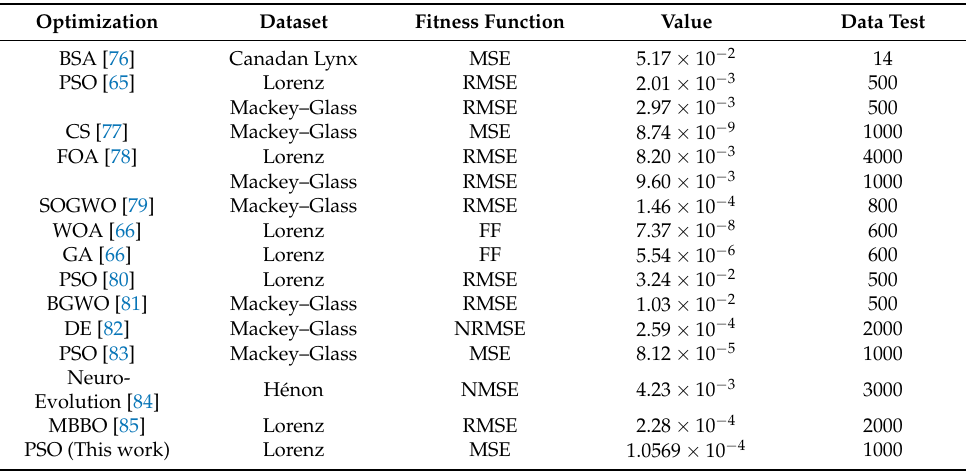
Table 5. Optimization algorithms applied to an ESN to predict chaotic time